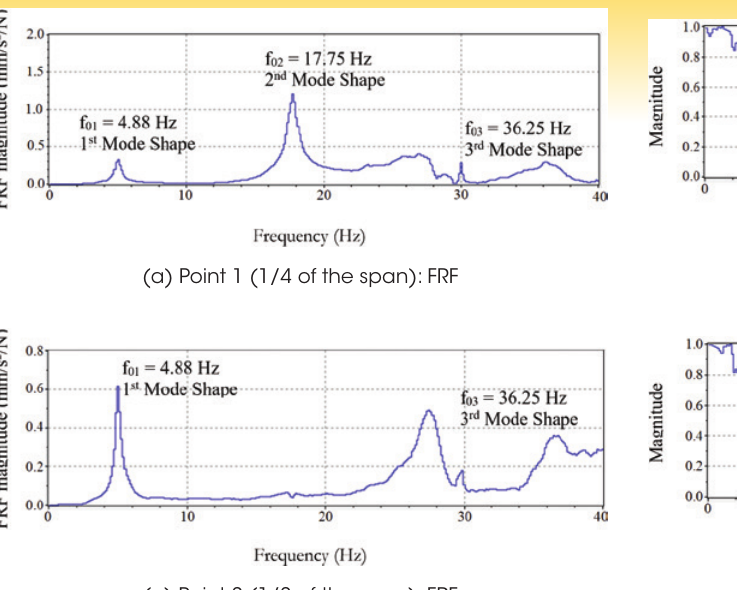
(d) Point 2 (1/2 of the span): Coherence